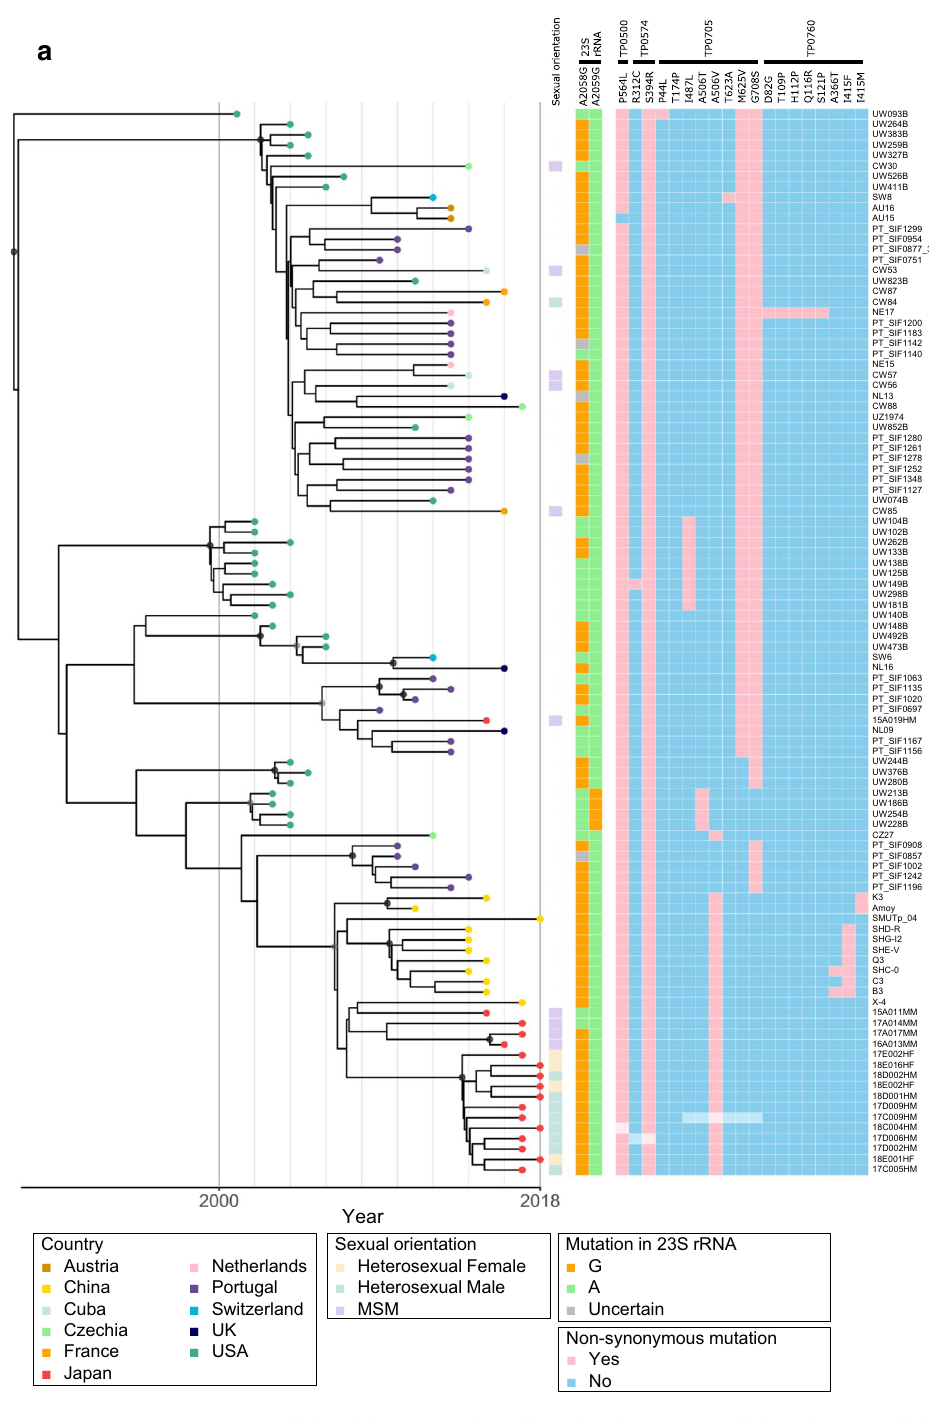
Figure 2. Bayesian maximum credibility phylogenetic analysis of 102 clinical Treponema pallidum subspecies pallidum genomes. ( a ) Time scaled phylogenetic tree of the TPA genomes in this study. ( b ) Expanded view of East Asian cluster- related node. The colored nodes represent the country of origin of the TPA genomes. The branch point nodes are shaded to indicate the posterior support (black ≥ 96%, dark grey ≥ 91%). The boxes on the right indicate the sexual orientation of the patient, the resistant mutations in the 23S rRNA genes, and the non-synonymous mutations in the penicillin-binding protein genes as shown in the legends. For the 23S rRNA genes, orange and green colors indicate the resistant-type and wild-type sites, respectively. For the penicillin-binding protein genes, pink and blue colors indicate the mutant and wild- type sites, respectively. The boxes with light-colored squares are single nucleotide polymorphism (SNP) sites that were not detected in the draft genome, and were determined by PCR-based Sanger sequencing with the primers shown in Table S2. The divergence estimates (95% HPD) of the time of each node are shown as follows: I, 1998 (1995–2002); II, 2002